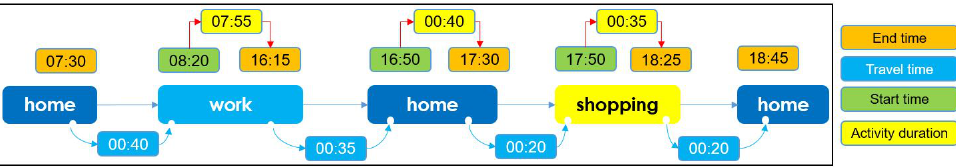
Figure 2. An overview of the model output: activity-settings (start-time, duration and end time) and trip-travel